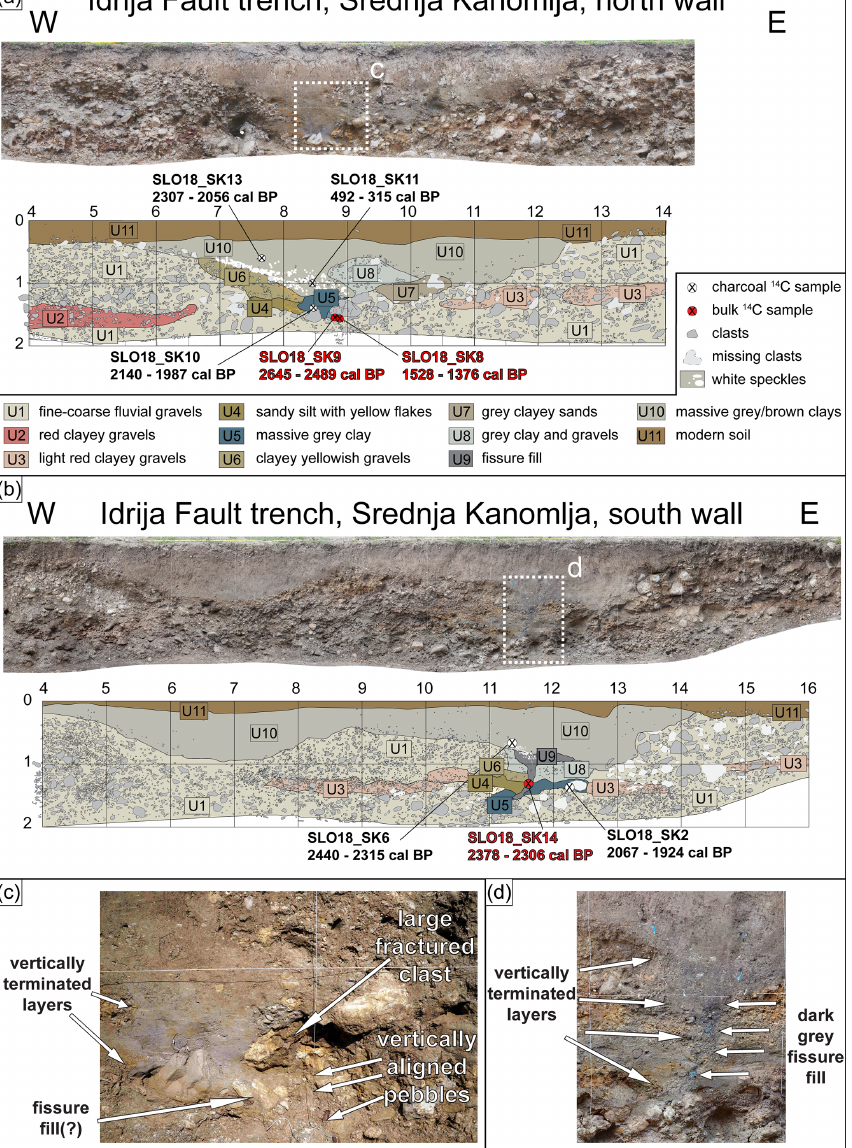
Figure 11. Results from the Idrija Fault trench at Srednja Kanomlja. (a) Orthophoto and trench log of the northern trench wall. (b) Orthophoto and trench log of the southern trench wall. Note that the photo and log have been flipped for easier comparison with the northern wall. (c) Close-up photo of the fault zone in the northern trench wall. Note the vertically terminated layers and the aligned pebbles below the massive, fractured clast. (d) Close-up photo of the fault zone and the fissure fill observed in the southern trench